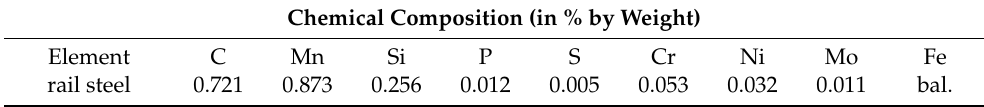
Table 1. Chemical composition of the investigated R260 steel. Chemical Composition (in % by